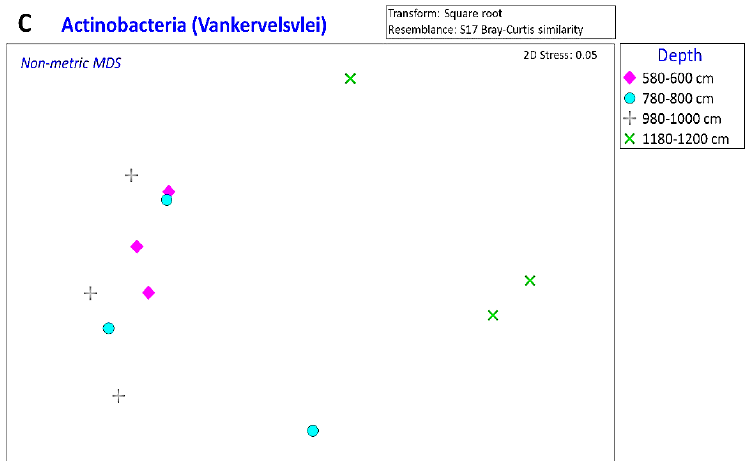
Figure 5. Non-metric multidimensional scaling plot showing similarities of the actinobacterial ( A ) and fungal ( B ) community structure from all the sites at different depths, and the actinobacterial community structure ( C ) from Vankervelsvlei at different depths. ‘Top’ = 0 to 5 cm depth, ‘middle’ = 25 cm depth, ‘bottom’ = 50 cm depth. NR = Nuwejaars River (developing peatland); GK = Goukou River (impacted peatland); VV = Vankervelsvlei (undisturbed peatland).